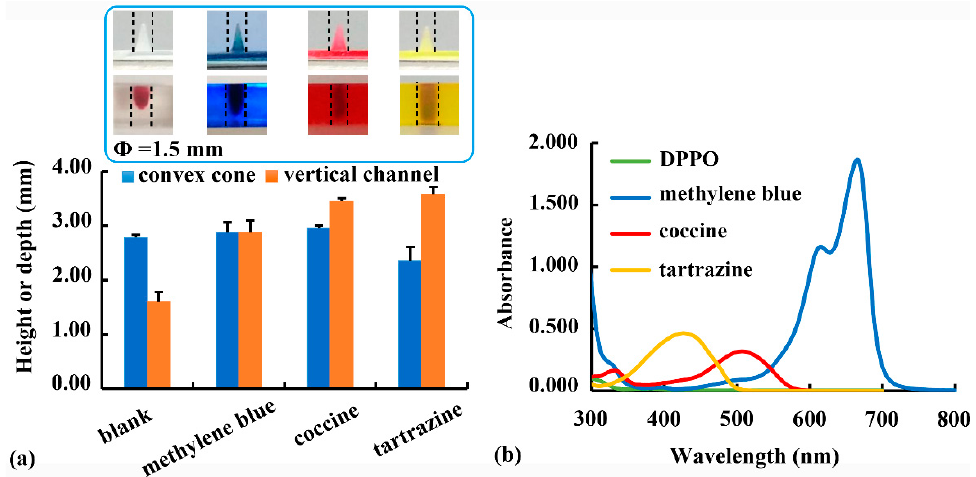
Figure 3. ( a ) Effect of different photoabsorbers (i.e., methylene blue, coccine, and tartrazine) on the printability of convex cone and vertical channel; ( b ) wavelength scan results of the photoinitiator (i.e., Diphenyl (2,4,6-trimethylbenzoyl) phosphine oxide, DPPO) and photoabsorbers. Diphenyl (2,4,6-trimethylbenzoyl) phosphine oxide, DPPO) and